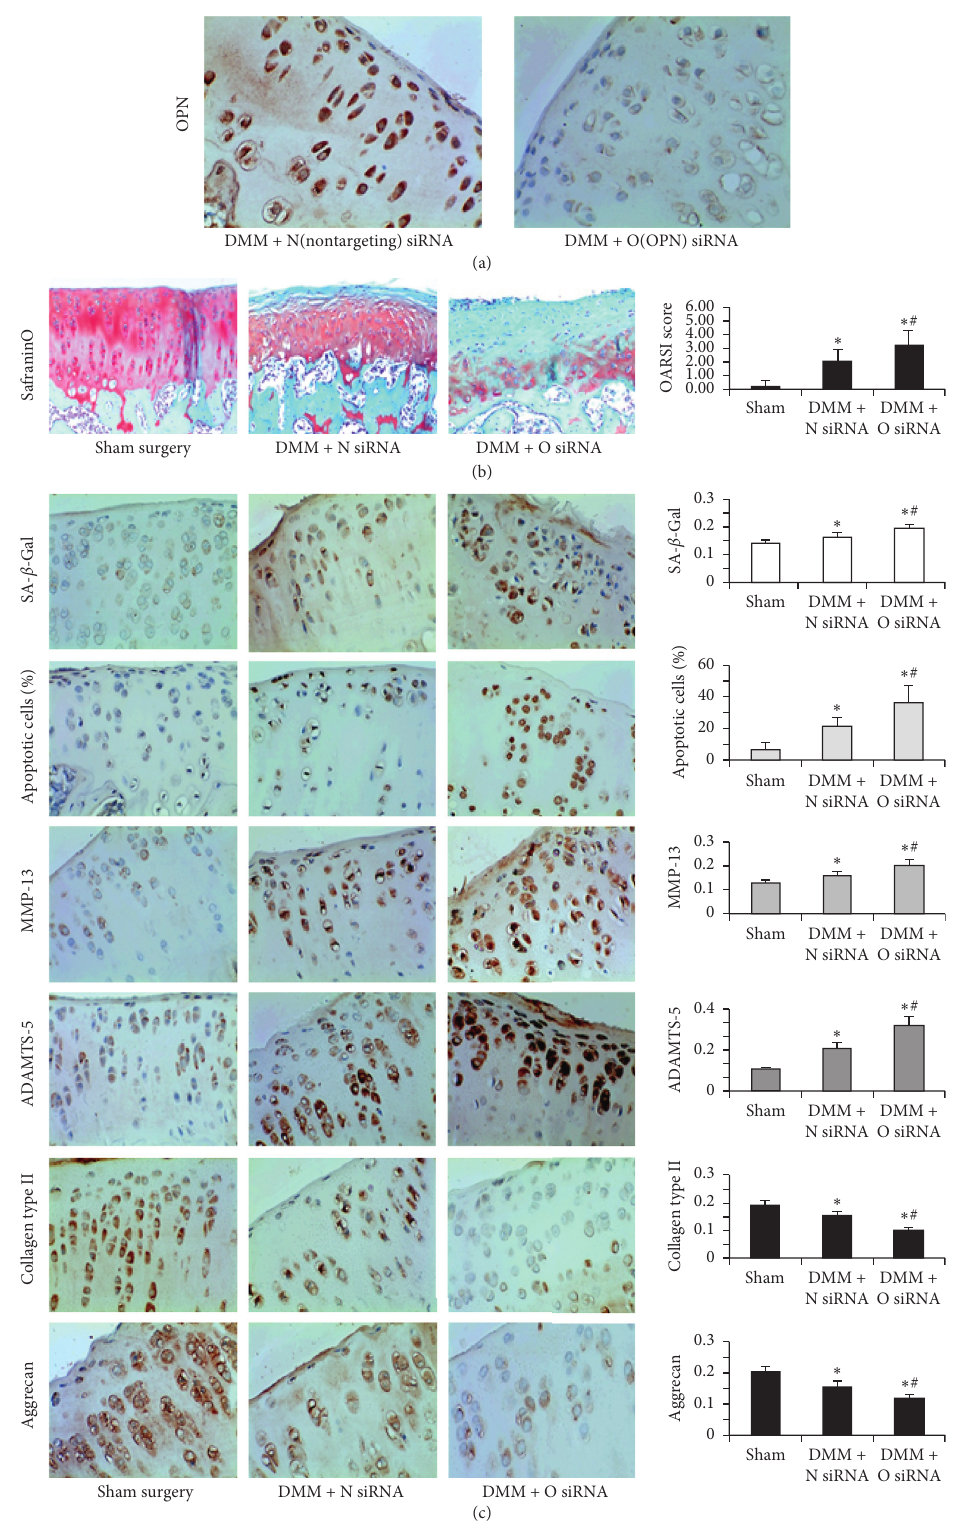
Figure 3: In vivo study of the role of OPN deficiency in OA. (a) Immunohistochemistry was employed to evaluate the knockdown efficiency of OPN siRNA. (b) Safranin O staining of cartilage was performed and OARSI scores were compared among the three groups. (c) The expressions of SA- β -Gal, MMP-13, ADAMTS5, collagen type II, and aggrecan and the chondrocyte apoptosis percentage were compared among the three groups ( ∗ p < 0 . 05 vs sham, # p < 0 . 05 vs DMM +nontargeting